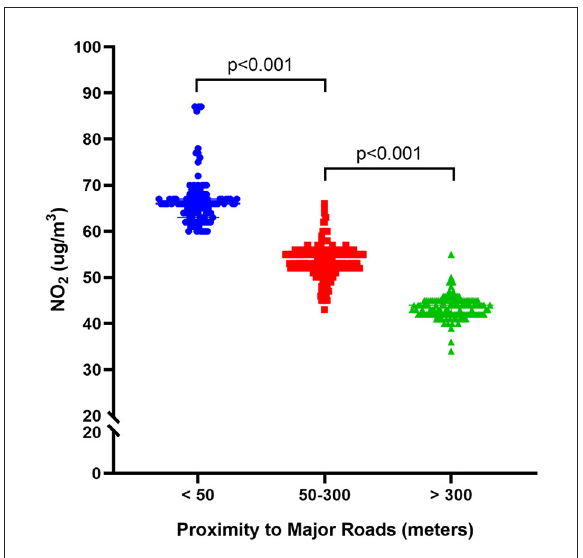
FIGURE2 Long-term exposure to NO2 and risk of the residential proximity to roads for osteoporotic